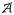
A. Gene tree showing a chromosome at the focal base (white) as the terminus of branch A, which has length tc, and a sister clade (blue) which share a branch S of length φ. B. Two situations regarding the maximum shared haplotype (msh) and the closest mutation on either branch A or S(xAS). Each is depicted as a genealogy (left side) and an adjacent alignment of the focal chromosome with its sisters (only the alignment to the right side of the focal base is shown). Each branch is labeled with the distance from the focal base position to the most proximal mutation to arise on that branch. Numbers in black are distances to events that may contribute to both msh and xAS. Numbers in brown are distances that can only contribute to the observed msh but not xAS as they involve events that did not happen on branch A or S. Each mutation is shown as an X mark in the corresponding chromosome alignment. Top panel: Not all sister chromosomes have mutations closer than the mutations on A or S, thus msh = xAS. Bottom panel: msh is less than xAS as both sister chromosomes have independently acquired mutations closer to the focal locus than mutations on branches A or S.